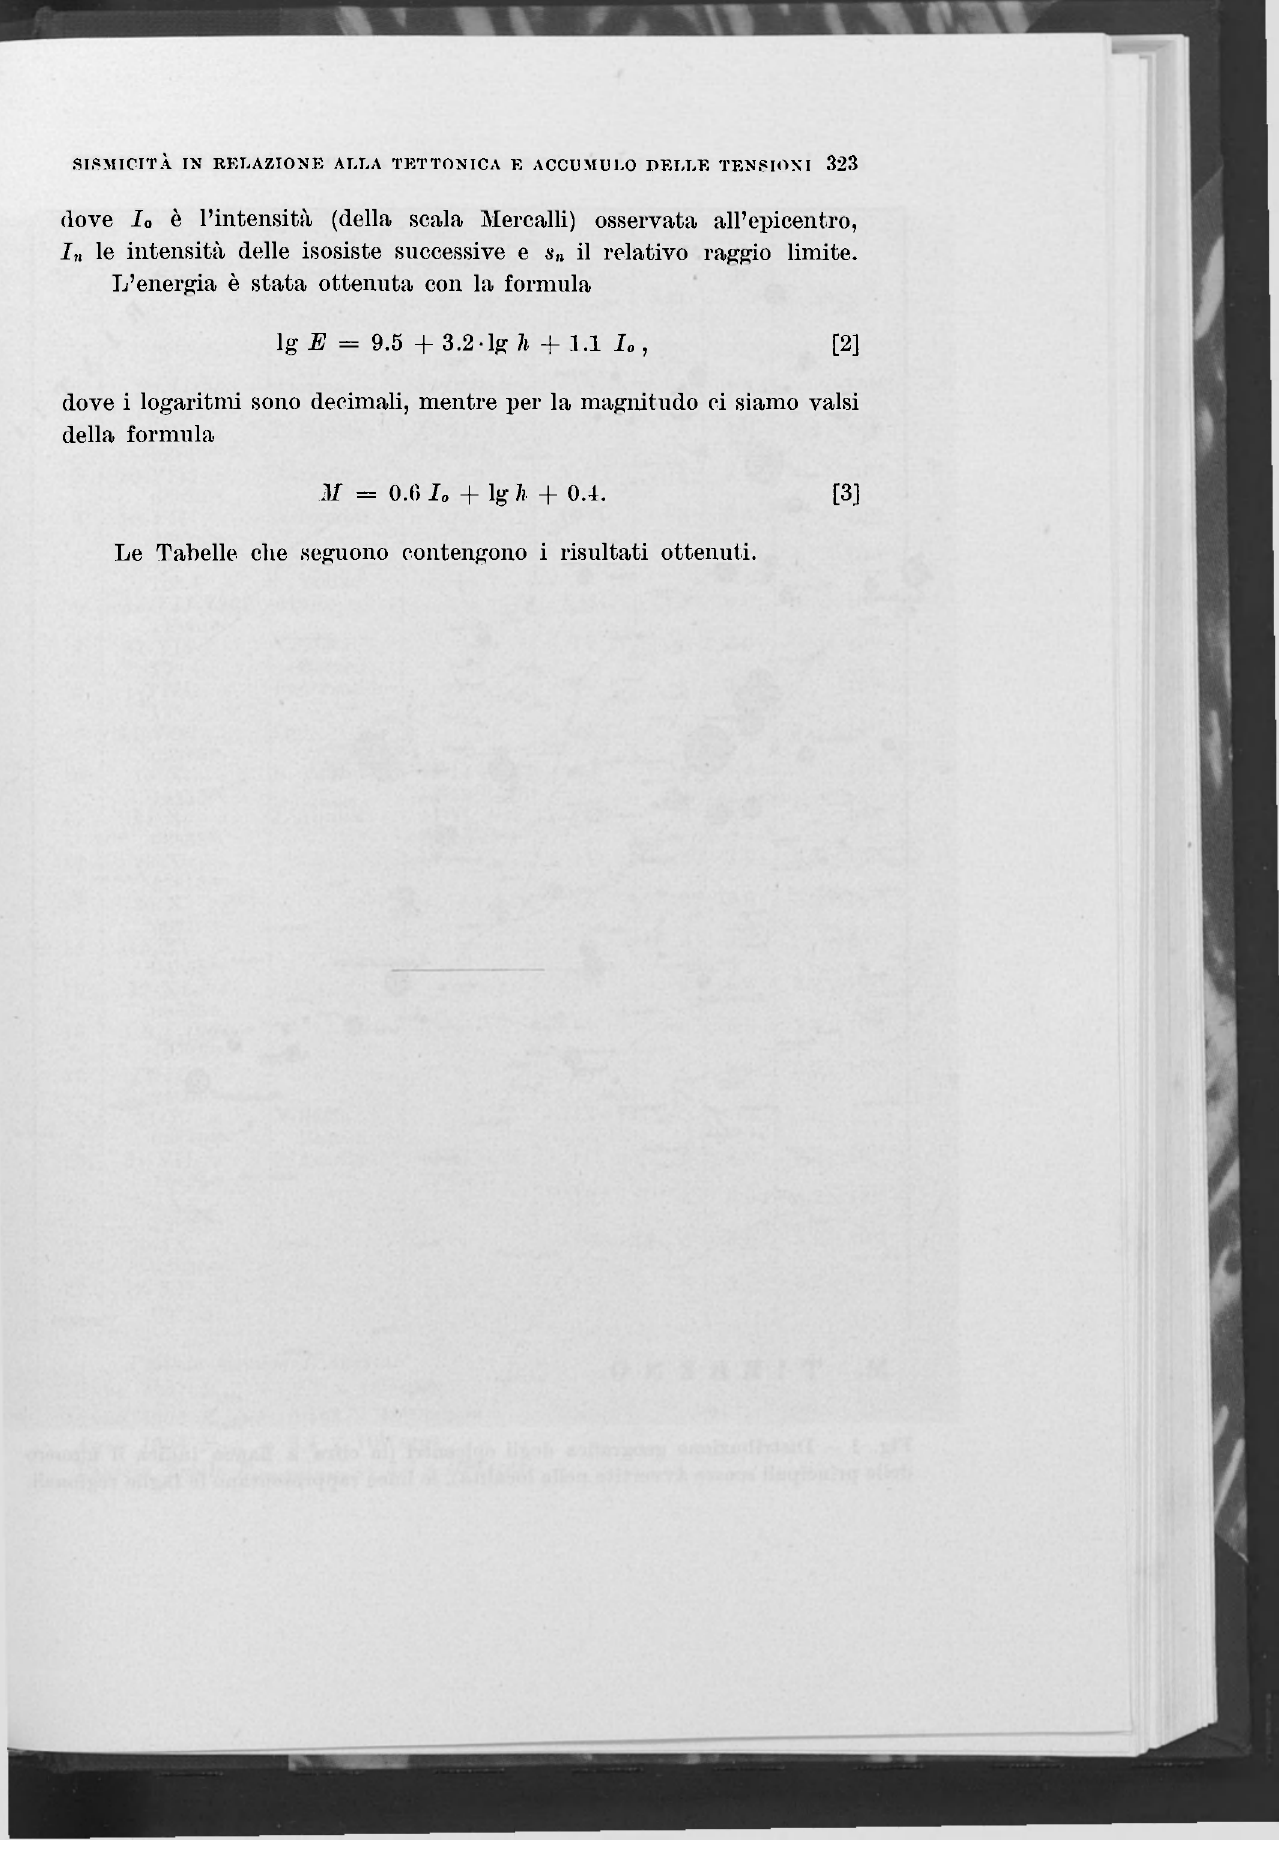
Le Tabelle che seguono contengono i risultati